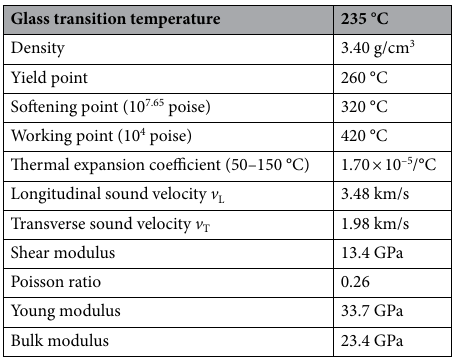
Table 3. Thermal and elastic properties of the LKSP glass.